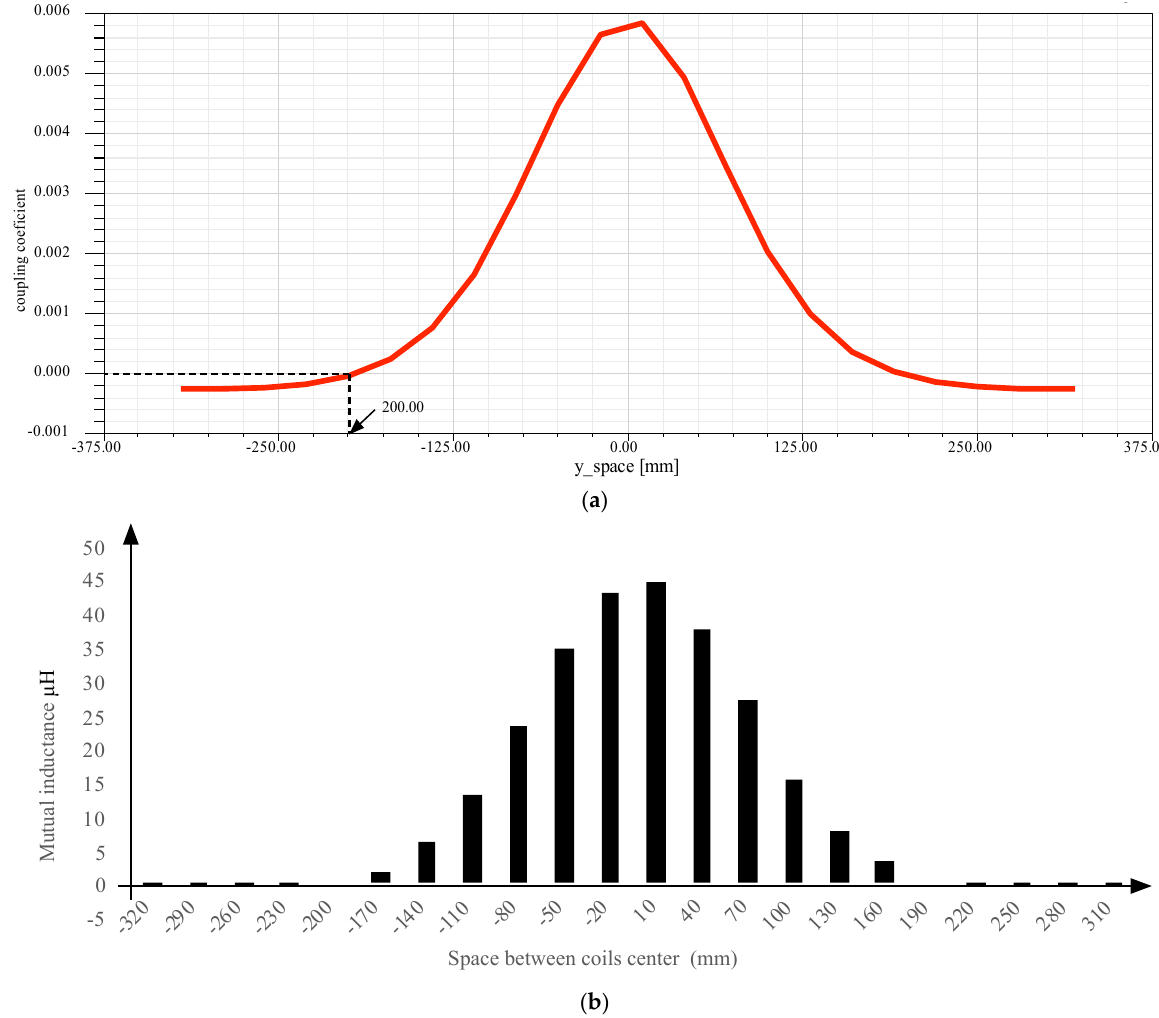
Figure 8. Coil model: ( a ) Coupling coefficient versus the gap variation, ( b ) mutual inductance versus the gap variation.